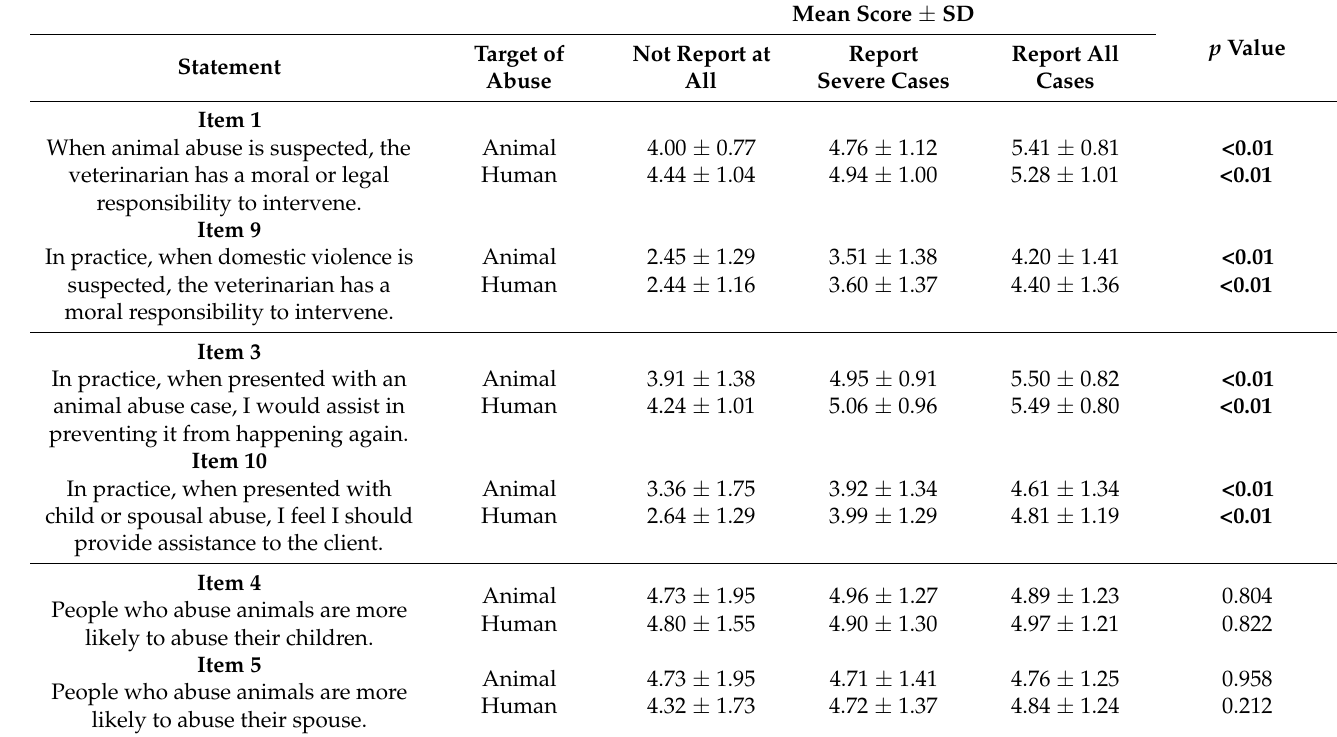
Table 4. A comparative analysis of veterinarians’ willingness to report abuse cases and veterinarians’ attitudes toward abuse